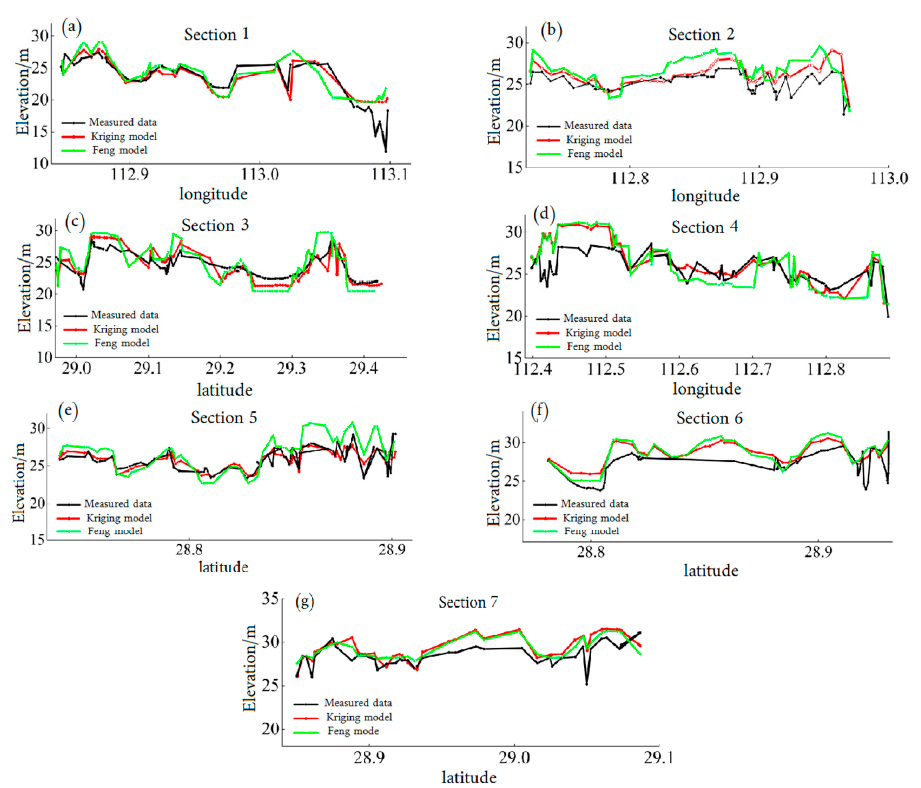
Figure 16. Comparison of measured and extracted cross sections.